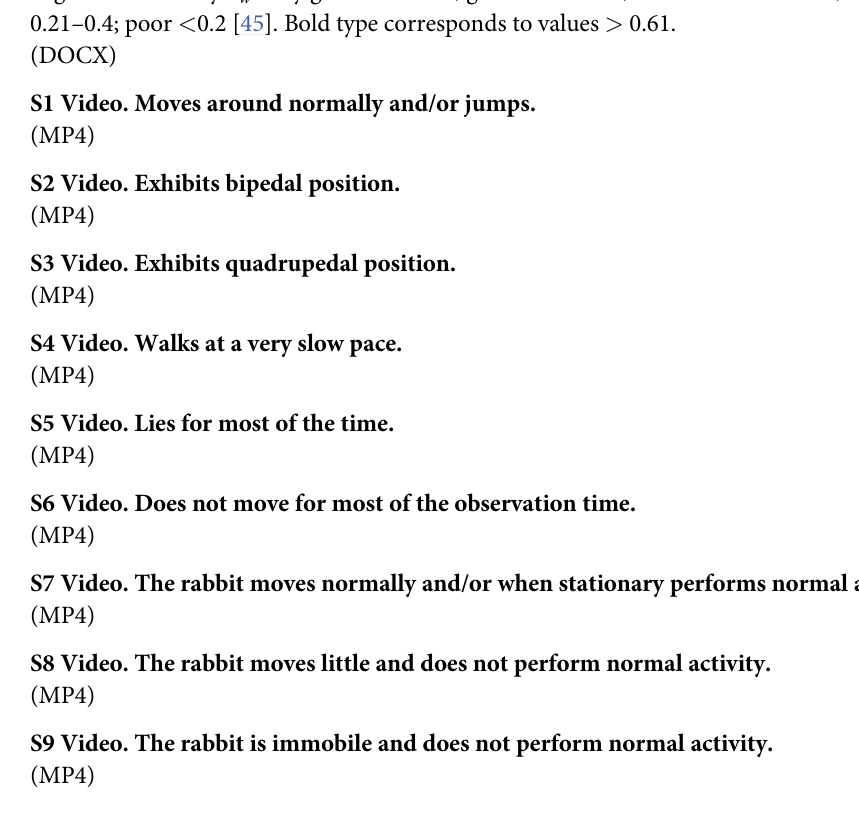
S4 Table. Inter-observer matrix agreement of items of the RPBS. Interpretation of the degree of reliability k : very good: 0.81–1.0; good: 0.61–0.80; moderate: 0.41–0.60; w